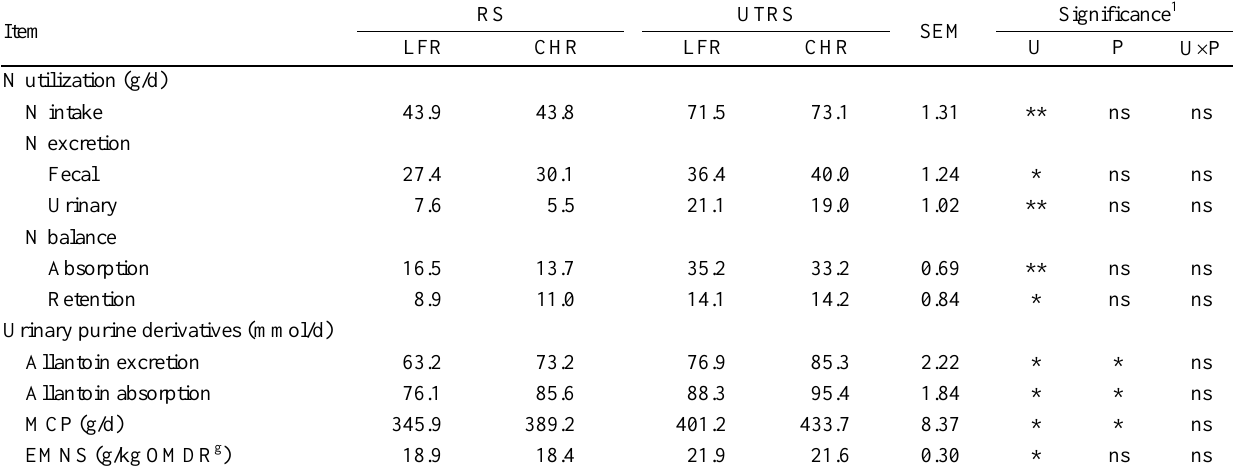
Table 4. Effect of physical form and urea treatment of rice straw on N balance, urinary purine derivatives and MCP synthesis in dairy